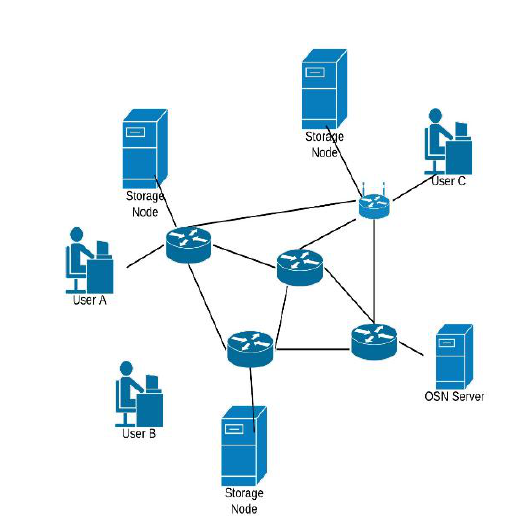
Figure 2. Peer-to-Peer